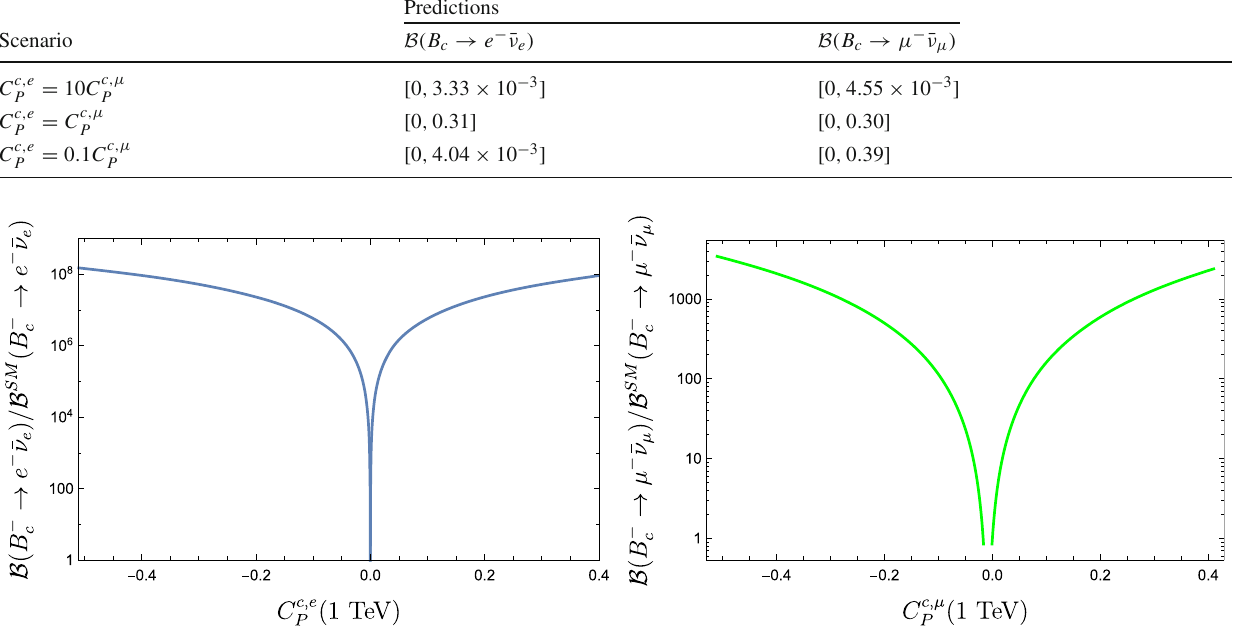
Fig. 19 Dependence of B ( B c → (cid:2) (cid:6) ¯ ν (cid:2) (cid:6) ) normalized to its SM value on C c , e